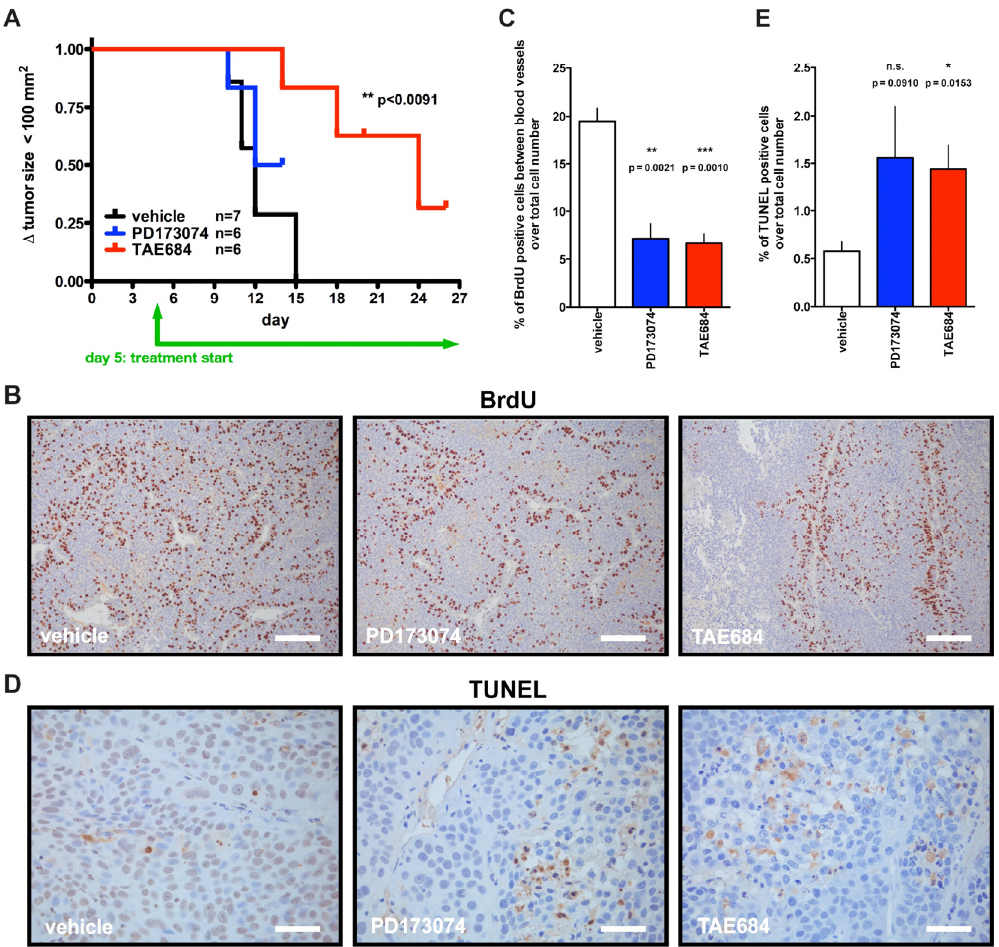
Figure 6. Effect of PD173074 and TAE684 treatment on COLO357PL tumor xenografts. ( A ): Kaplan– Meier plot of tumor growth >100 mm 2 during the three-week treatment period. TAE684 vs. control; p -value by Gehan–Breslow–Wilcoxon test is indicated. PD173074 p > 0.05 vs. control. ( B , C ): BrdU staining for proliferating cells. Representative images of immunostaining are shown. Scale bar, 0.2 mm ( B ). Proliferating cells > 3 cell layers distant from blood vessels were quantified ( C ). A minimum of 22 images per group (total of 71) were analyzed. ( D , E ): TUNEL staining for apoptotic cells. Rep- resentative pictures are shown. Scale bar, 0.05 mm ( D ). Panels ( B – E ): Vehicle treated mice, n = 4; drug treatment groups, n = 3 each; mean + SEM; p -values from unpaired two-tailed t -test. Taken together, the distinct outcome from this longer-term study based on the kinase inhibitor used is consistent with the distinct response of circulating miRs derived from the seven-day treatment (Figures 3A,B and 5A,B, Table 2). Given that the changes in serum miRs occurred before observable changes in tumor size, this suggests that a therapeutic response can become apparent from an early analysis of changes in circulating miRs. 4. Discussion In the present study, we evaluated the utility of changes in circulating miR signatures as readouts of drug efficacy. We first needed to establish a ‘diagnostic’ set of circulating miRs associated with the presence of tumor xenografts. From our study of serum miRs in the xenograft models of pancreatic (COLO357PL) and breast (MDA-MB-231) cancer, we found two distinct miR profiles with an overlap in six serum miRs, three of which (let-7c, miR-103 and miR-215) changed in the same direction in both cancer types (Figure 4, Table 1). Interestingly, loss of let-7 family members is associated with poorly differentiated ag- gressive cancers, including pancreatic and breast cancer [53–55]. The serum miR signature showed a marked ≥ 3-fold increase in miR-130a, miR-146b, miR-215, and miR-223 and a